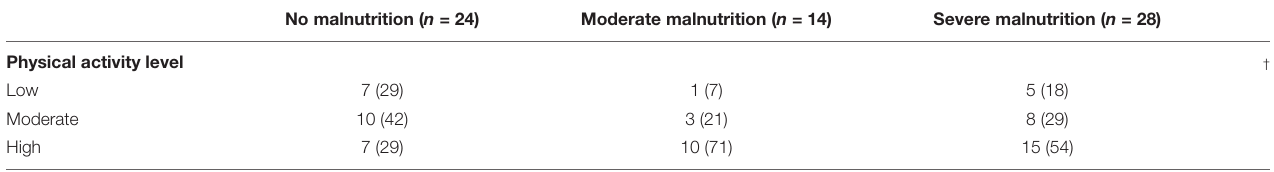
TABLE 6 | Reported physical activity levels of patients with chronic pancreatitis stratified by nutritional status. No malnutrition ( n = 24) Moderate malnutrition ( n =